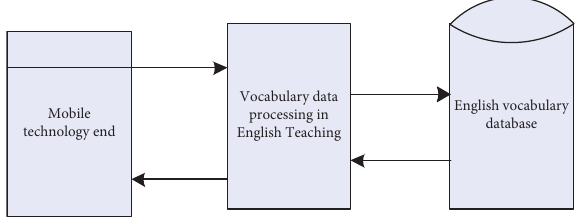
Figure 2: Basic operation flow of the user